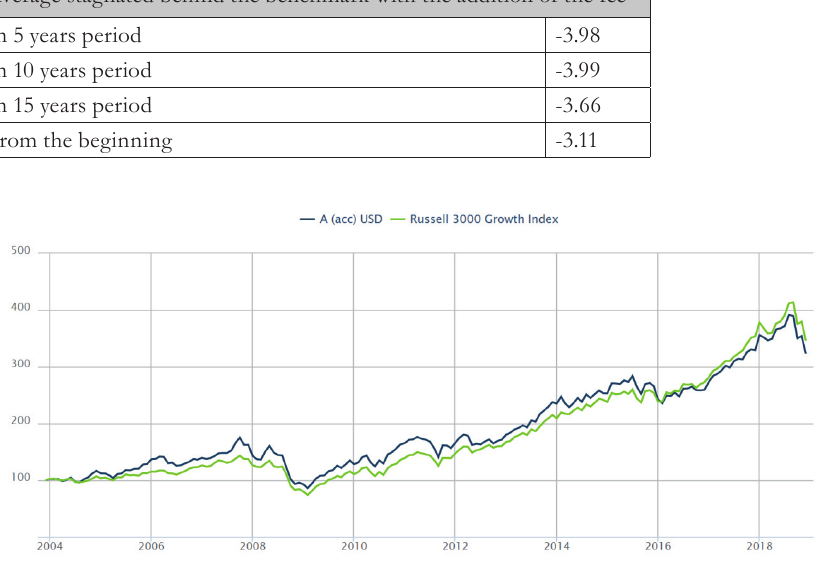
Fig. 1 – Performance of Franklin U.S. Opportunities Fund vs. Russell 3000 Growth Index. Source: Franklin U.S. Opportunities Fund